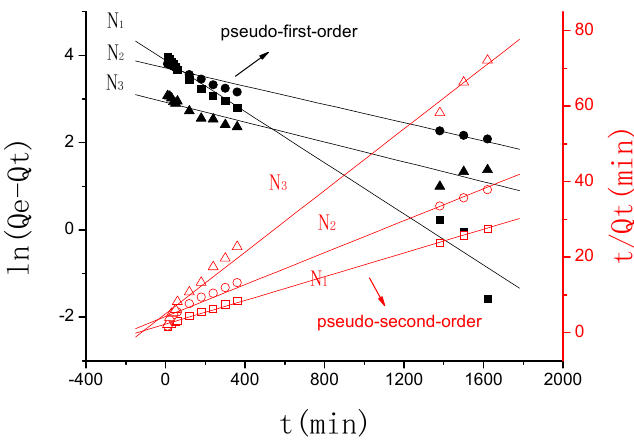
Figure 7. Pseudo-first-order and pseudo-second-order kinetic plot for the adsorption of γ -PGA/ ε -PL hydrogel in NaCl solution. Table 2. Constants and correlation coefficients of the two kinetic models for Na(I) adsorption onto γ -